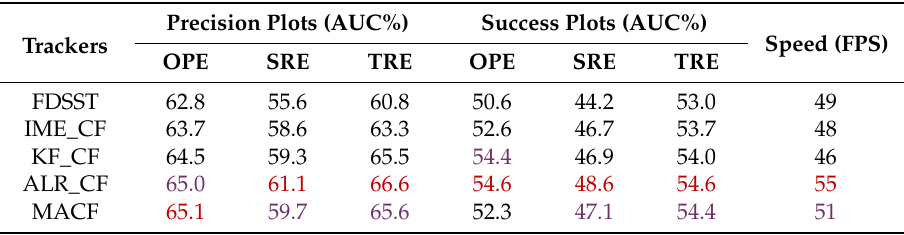
Table 1. The comparison of ablation results on OTB-50 dataset. Clearly, the success plots (SP) of one pass evaluation (OPE), temporal robustness evaluation (TRE), and spatial robustness evaluation (SRE) utilizing the location error threshold (LET) and the precision plots (PP) of OPE, TRE and SRE using overlap threshold (OT) and the tracking speed are shown in the table below. And the best results are in red and the second results are in blue. Trackers Precision Plots (AUC%) Success Plots (AUC%) Speed